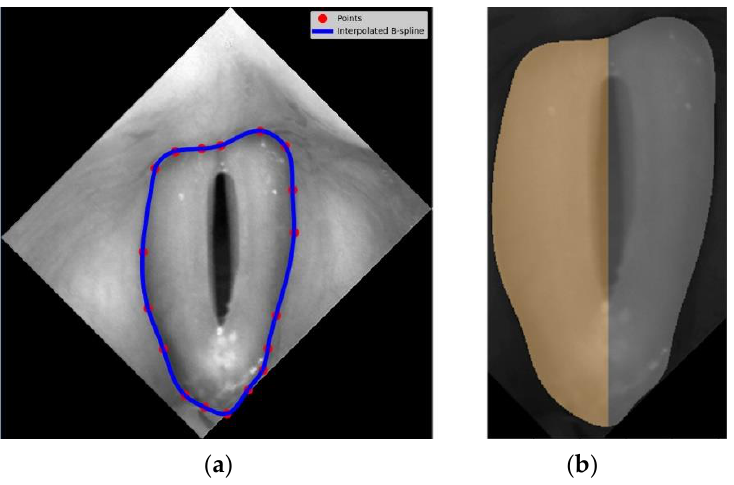
Figure 3. Identification of the region of interest for further image analysis procedures: ( a ) vocal fold area delineated with b-spline curves represented by blue line and the user-defined interpolation nodes, ( b ) identification of the left (grey shaded) and the right (orange shaded) vocal folds.